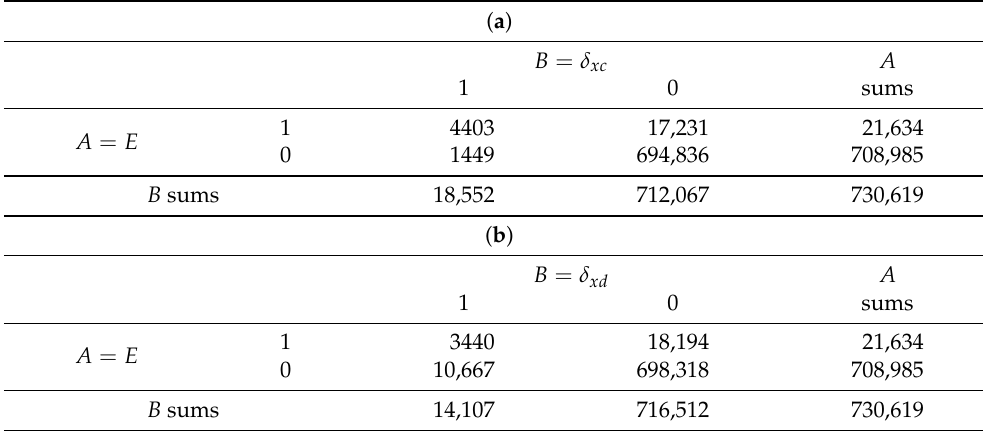
Table 7. Two-by-two contingency tables for coextremes of ( a ) rain and convergence ( A = E , B = δ xc ), and ( b ) rain and divergence ( A = E , B = δ xd